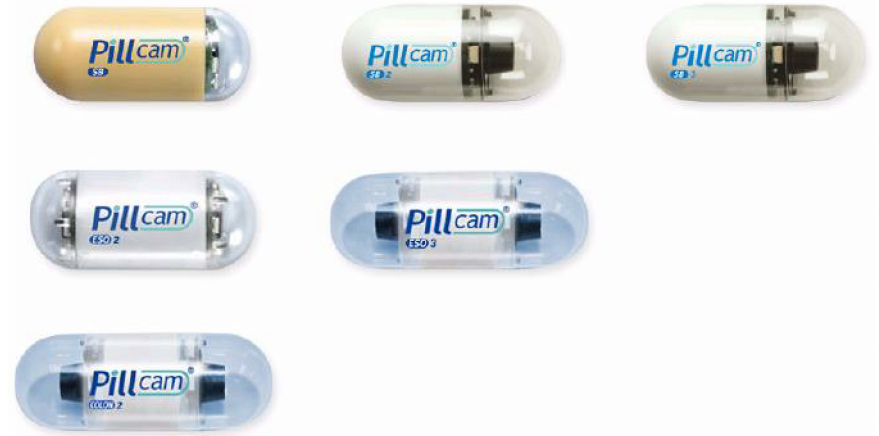
Figure 7. Pillcam Capsule endoscopy (image courtesy of Medtronic).